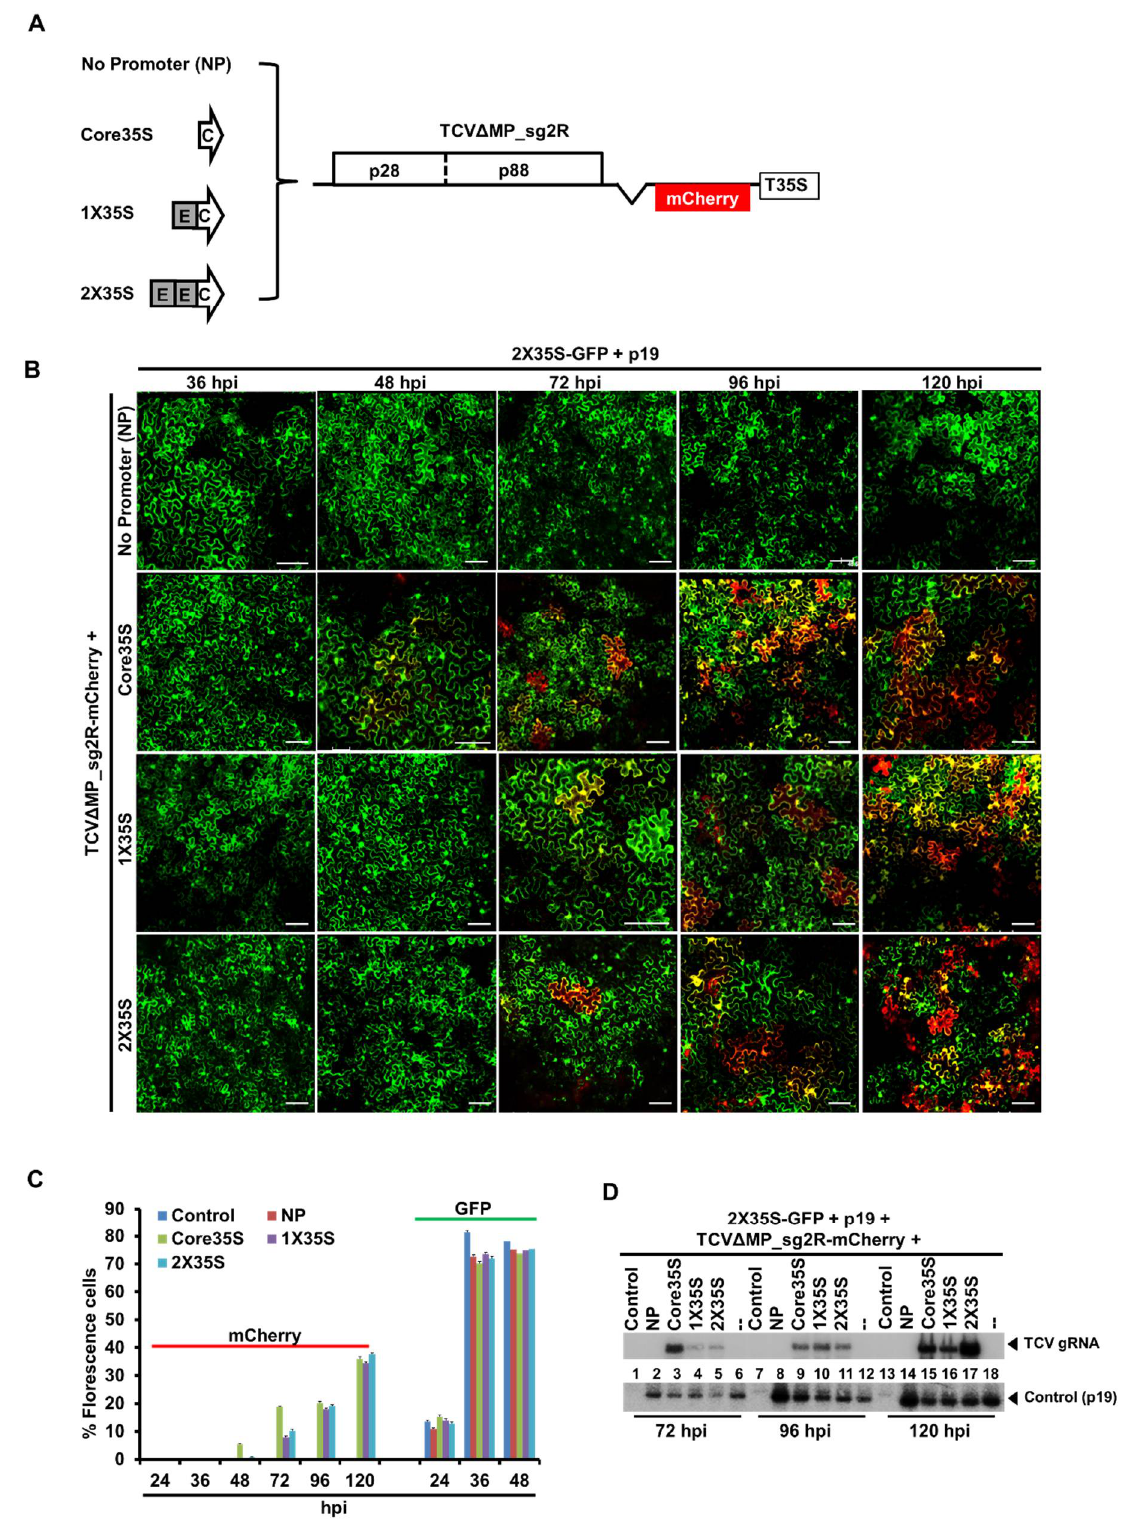
Figure 2. Replication efficiency of TCV-mCherry driven by the different strengths of the promoter variants. ( A ) Schematic representation of the four different 35S promoter-based TCVΔMP_sg2R-mCherry constructs; Core35STCVΔMP_sg2R-mCherry, 1X35STCVΔMP_sg2R-mCherry, 2X TCVΔMP_sg2R-mCherry, and NPTCVΔMP_sg2R-mCherry. ( B ) Microscopic (confocal microscopy) images of N. benthamiana leaves infiltrated with the different 35S promoter-based TCVΔMP_sg2R-mCherry with GFP and p19 constructs. The four different 35S promoter-based TCVΔMP_sg2R-mCherry constructs were delivered by agroinfiltration onto leaves of healthy N. benthamiana plants. A p19-expressing construct was